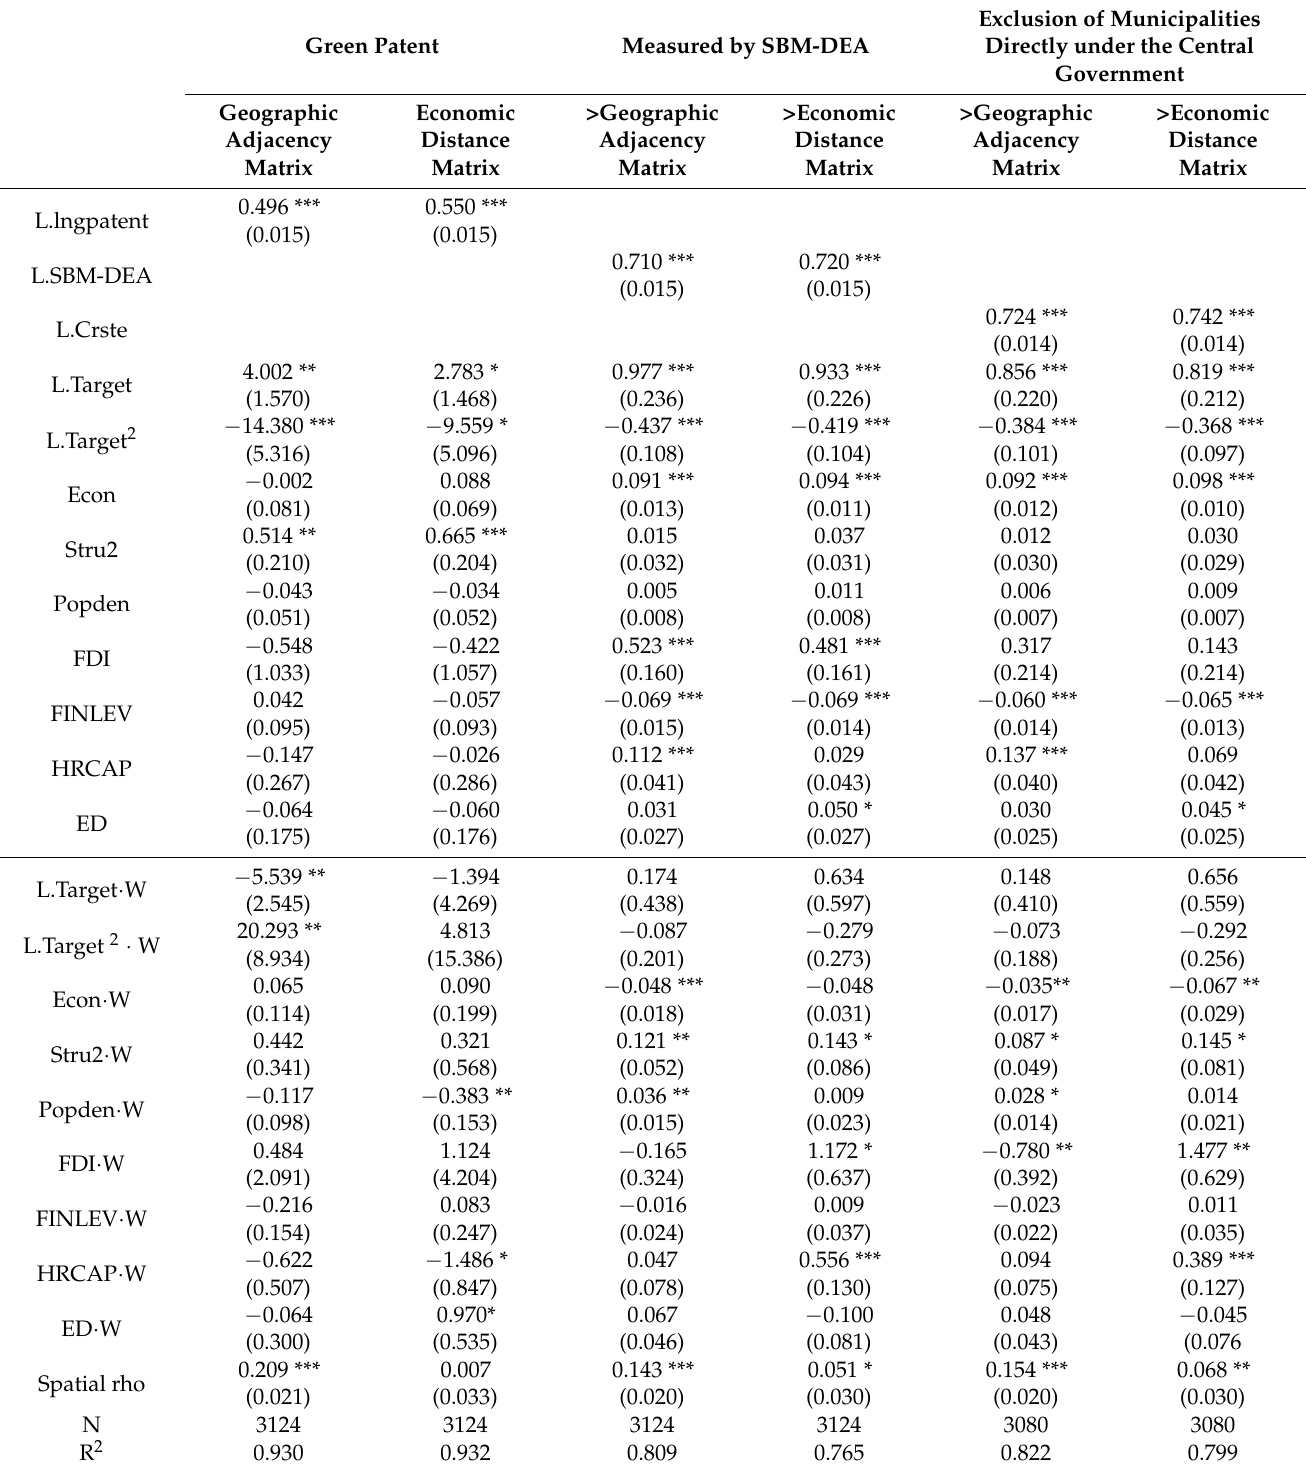
Table 7. Robustness